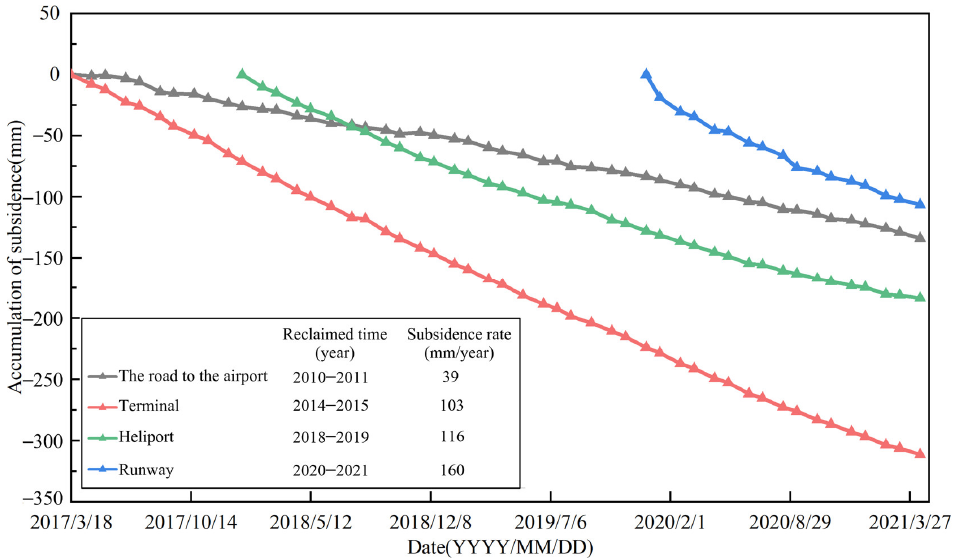
Figure 8. The accumulation subsidence in different areas of the airport. The location of P1–P4 were shown in Figure 6.